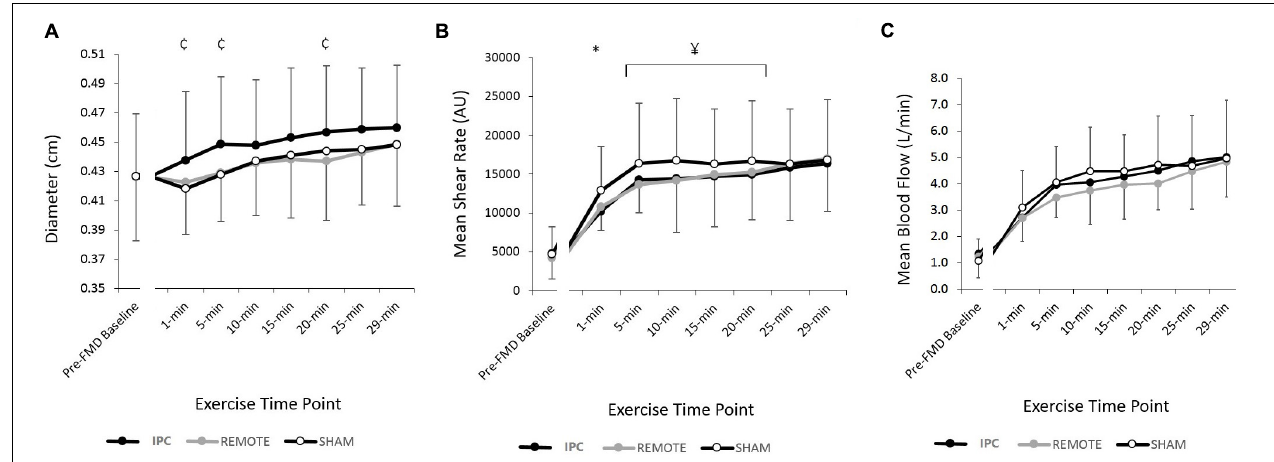
FIGURE 2 | Mean ± SD: data reported for (A) brachial artery diameter (cm) (B) shear rate (s − 1 ), and (C) blood flow (l/min) during 25% MVC handgrip exercise for each conditions. (cid:85) represents a significant difference between IPC and SHAM; significant difference between IPC and both conditions.